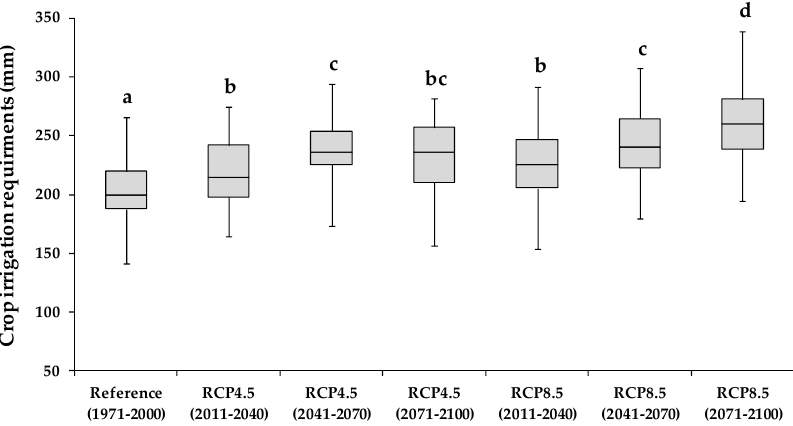
Figure 5. Box plots of crop irrigation requirements (mm) for the climate scenarios assuming current irrigation management (CIM). a–d letters indicate significant statistical differences at p = 0.05.